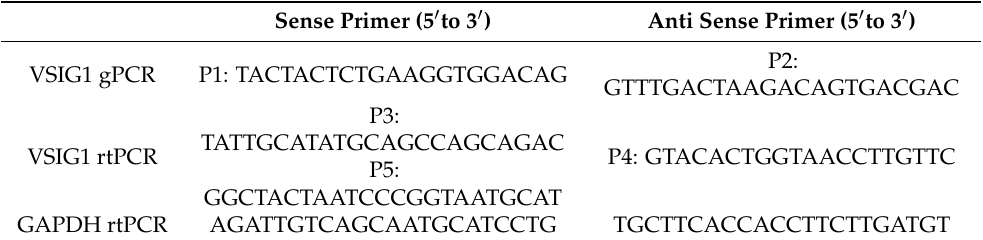
Table 1. Number of primer sequences for genomic PCR (polymerase chain reaction) and RT-PCR (reverse transcription